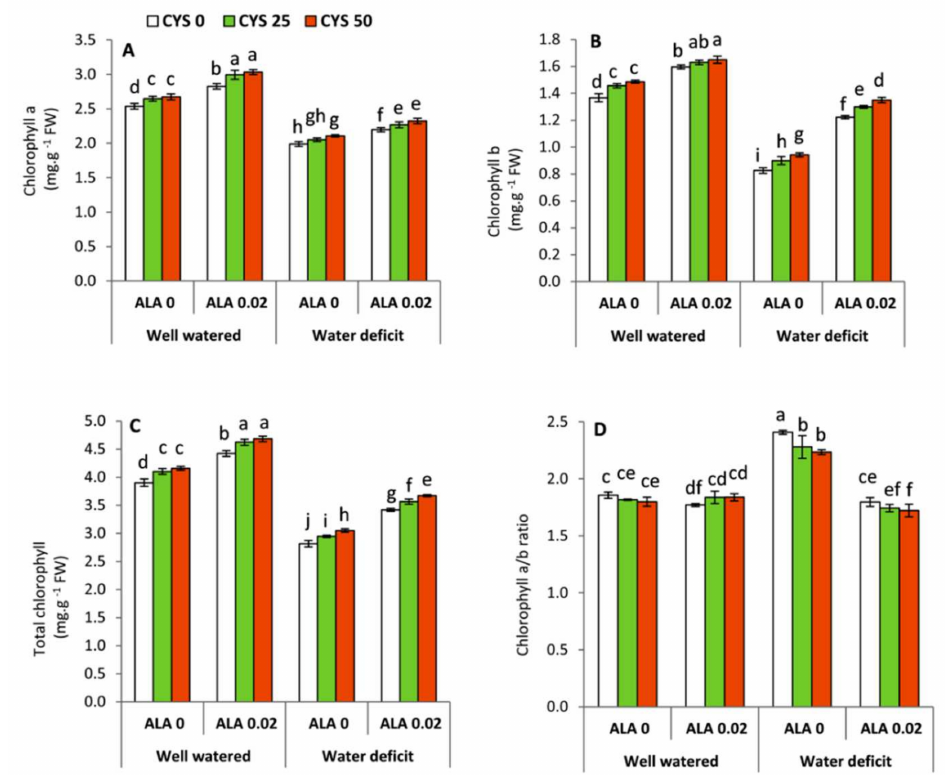
Figure 1. Effect of irrigation level, seed soaking by α -lipoic acid (ALA; 0 and 0.02 mM) and foliar application by cysteine (Cys; 0, 25 and 50 ppm) on the chlorophyll concentration of wheat plants. ( A ) chlorophyll a, ( B ) chlorophyll b, ( C ) total chlorophyll, ( D ) chlorophyll a/b ratio. For each parameter, the mean values ± SD followed by a different letter are significantly different according to Tukey’s range test ( p ≤